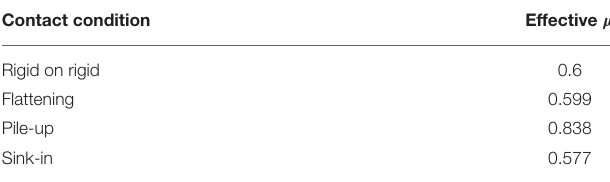
TABLE 4 | Effective coefficients of friction for different tangential